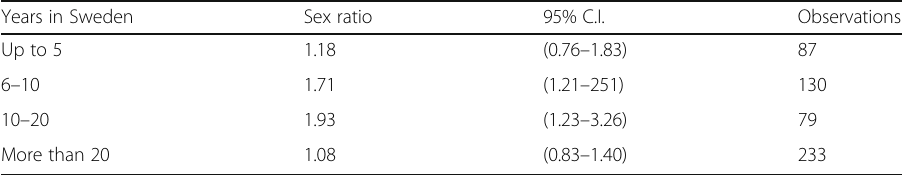
Table 4 Sex ratio at birth, 3rd births, for women coming from China, Korea, and India, by years in Sweden: Sweden, 1980 – 2015